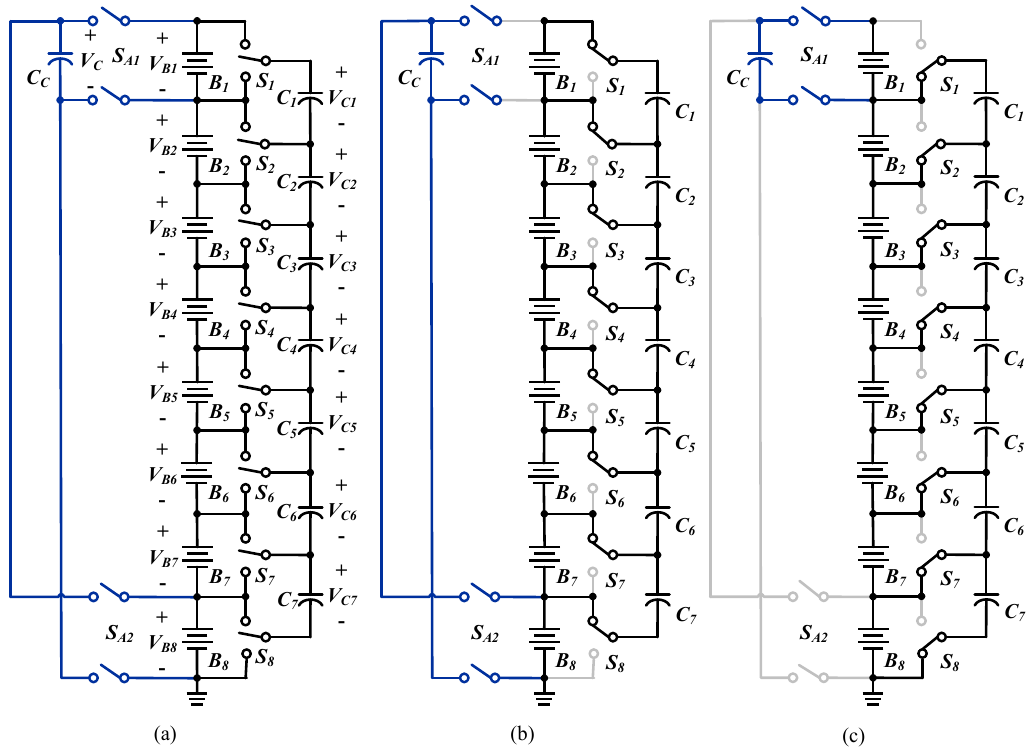
Figure 4. Chain structure of SC-based BE type I*: ( a ) circuit architecture; ( b ) first state; ( c ) second state. * Eight batteries are shown as examples.